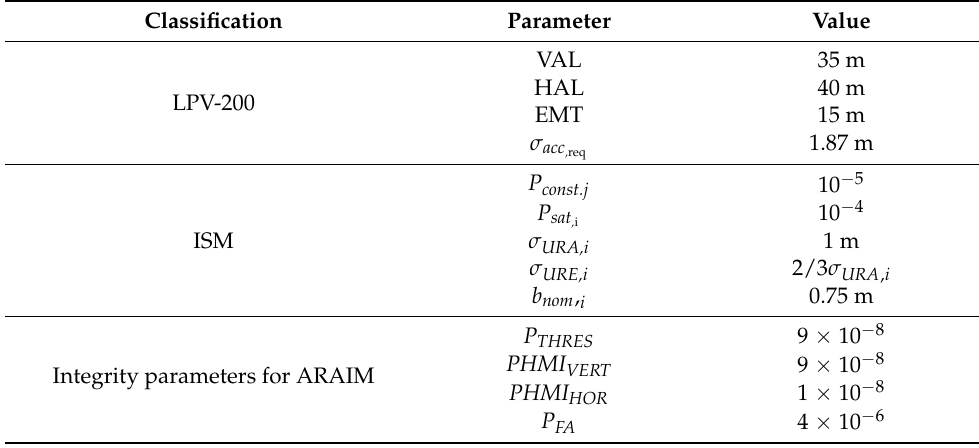
Table 1. Parameters for ARAIM availability